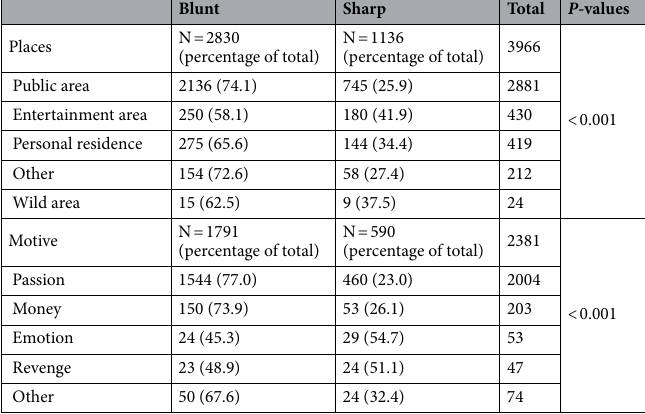
Blunt Sharp Total P -values